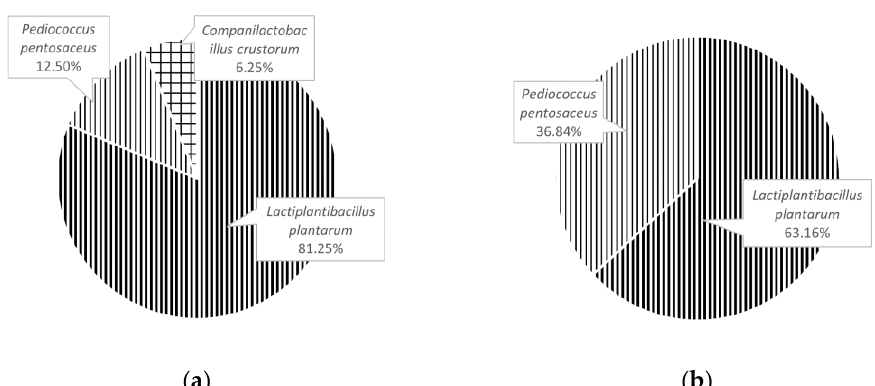
Figure 5. The percentage of different species or subspecies in the total strains isolated from XS